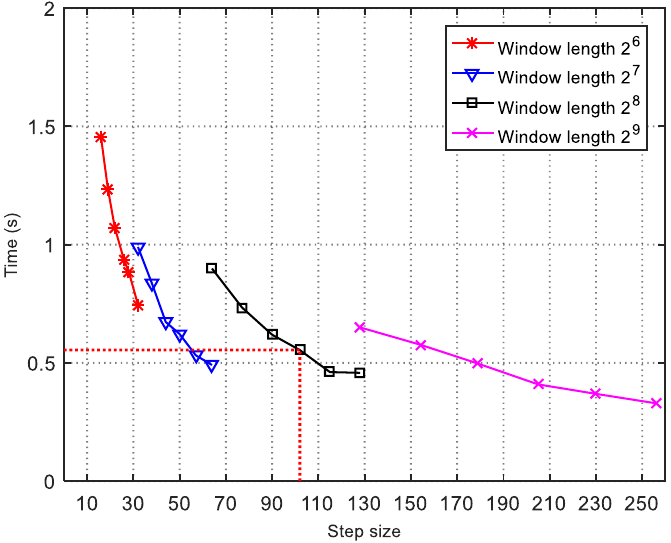
ff erent step sizes in four window Figure 2. Simulated time required for different step sizes in four window lengths. Figure 2. Simulated time required for di